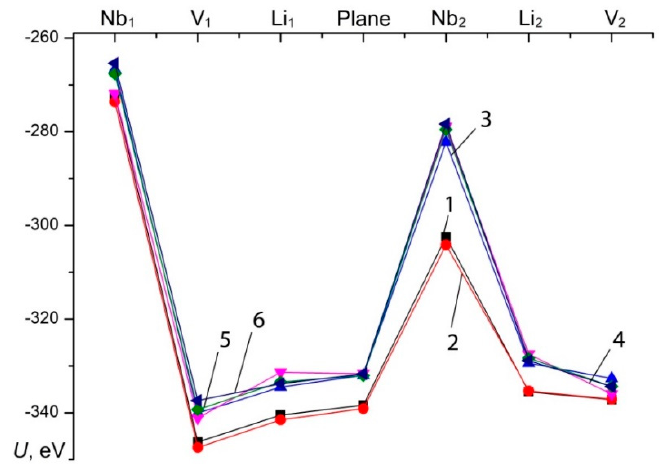
Figure 14. The total energy of the Coulomb interaction of point charges in a cluster consisting of two Li + cations, two Nb 5+ cations, one B 3+ cations, and twenty O 2 − anions. A Nb 1 –B 3+ pair is located in tetrahedron face bordering with NbO 6 of the first layer; a V 1 –B 3+ pair is located in tetrahedron face bordering a vacant octahedra of the first layer, etc. Т = 297 К (1), 523 (2), 773 (3), 1023 (4), 1273 (5), 1473 (6). The figure is reproduced with the permission of Pleiades Publishing from the paper R.A. Titov et al., Techn. Phys ., 2021 V. 66 № 1 P. 59–66, DOI: https://doi.org/10.1134/S1063784221010217 (accessed on 26 March